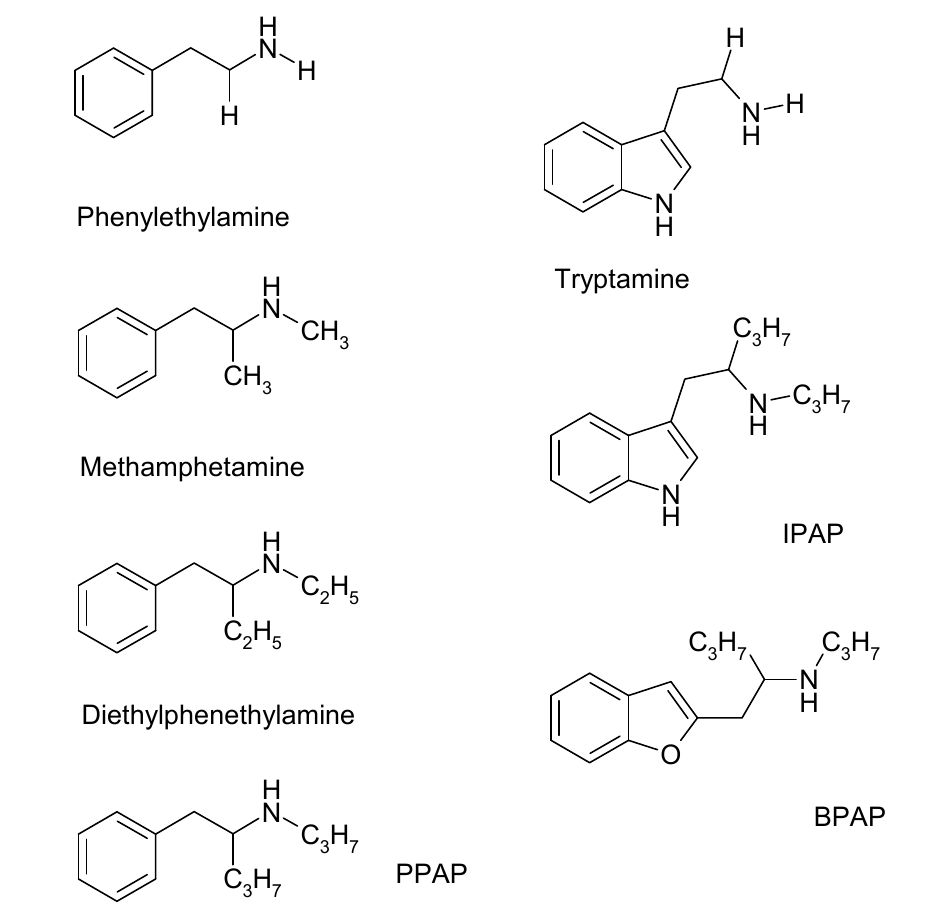
Figure 1. The chemical structure of trace amines (phenylethylamine, tryptamine), phenylethylamine analogues (methamphetamine, diethylphenethylamine), and enhancer substances (PPAP, IPAP, BPAP).